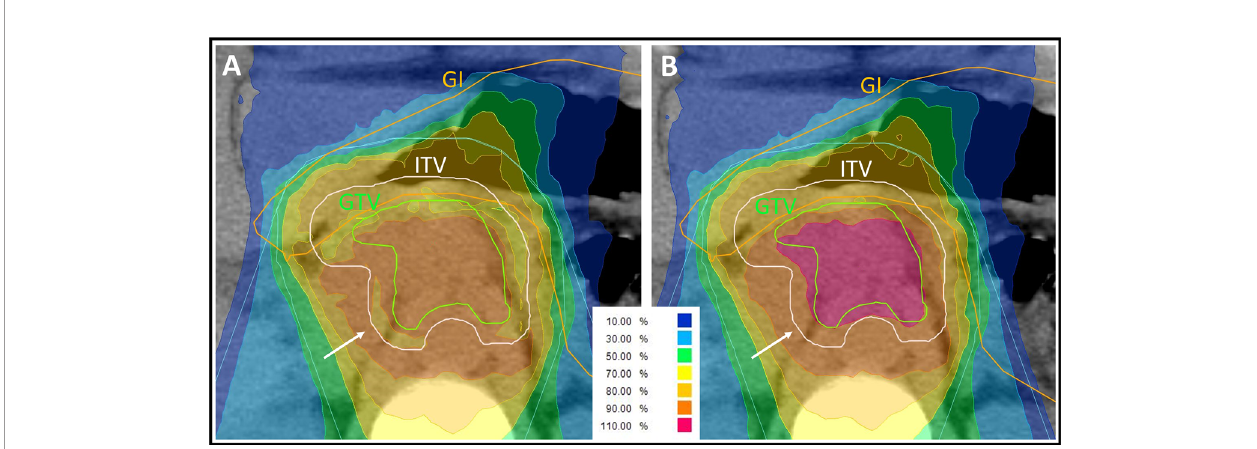
FIGURE 1 | Representative carbon ion radiation plan of a locally advanced pancreatic cancer patient using a clinical a / b -ratio of 5 Gy for the internal target volume (ITV) and 2 Gy for the surrounding tissue in the treatment planning software ’ s integrated relative biological effectiveness (RBE) model. The isodose lines are demonstrated in different colors. The percentages of the isodose lines shown in the legend correspond to the prescribed dose of 48 Gy (RBE) in 12 fractions. Underdosage of the ITV and of the gross tumor volume (GTV) needed to be accepted to respect the gastrointestinal (GI) constraints. (A) Due to the a / b -ratio shift at the edge of the ITV, the peripheral ITV is irradiated with a lower biological dose than the surrounding tissue (white arrow), whereas the physically applied dose is increasing towards the center of the ITV. (B) Forward calculation using an a / b -ratio of 2 Gy for all volumes in the RBE model. The dose distribution at the edge of the ITV is more homogenous (white arrow) but in this plan presentation, the GTV seems to be overdosed. This forward calculation helps in analyzing the plan but is not assumed to be correct, because of the missing biological assumption of the higher a / b -ratio for the